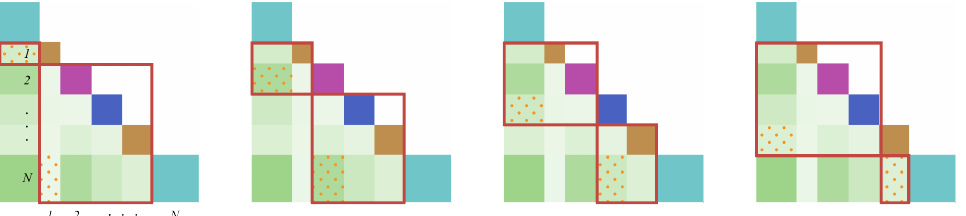
Figure 9. Examples of conceptual similarities used in the Point method. Each red square represents a topic segment. The light green squares with orange dots inside the red squares indicate the conceptual similarities used in the Point